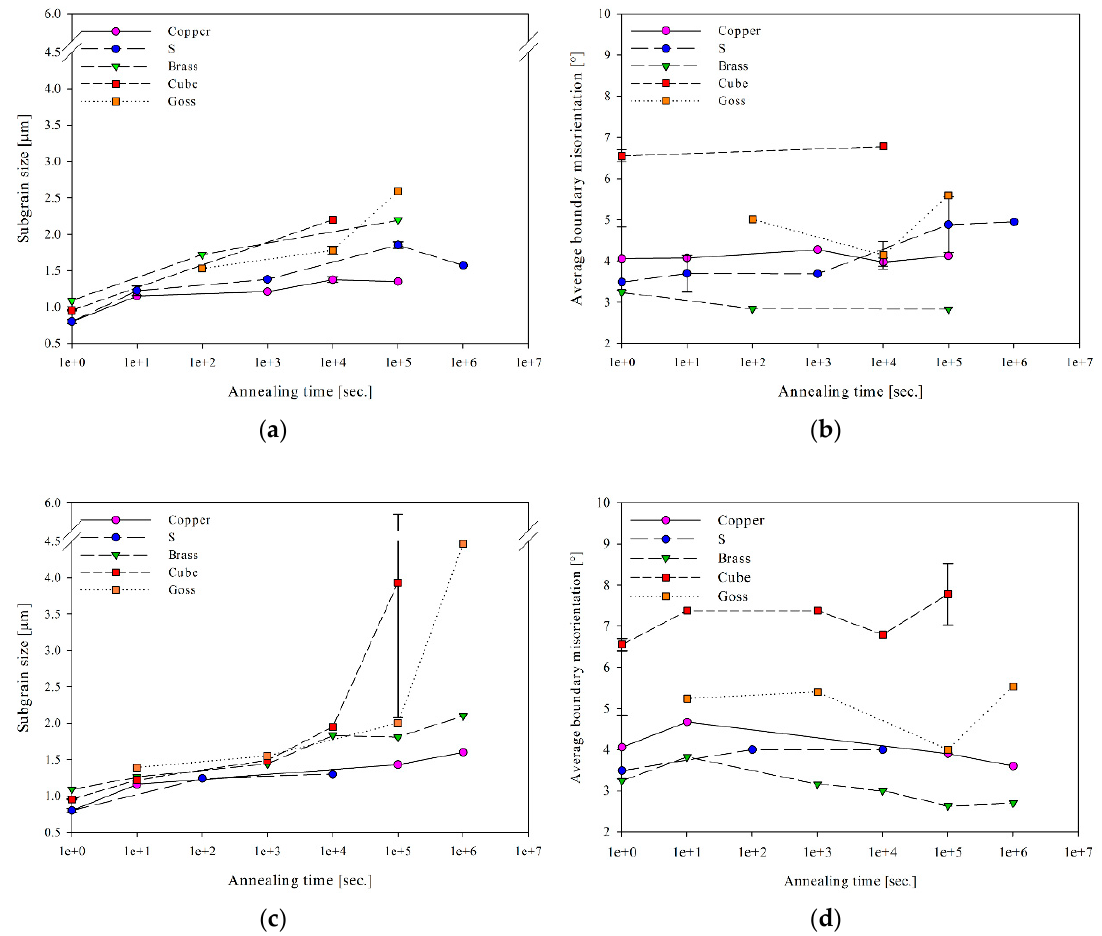
Figure 4. The evolution in average subgrain size ( a, c ) and boundary misorientation ( b, d ) during annealing of HP Al at 200 °C and at 220 °C, respectively. The as-deformed state is given at t = 1 s. Error bars reflect the scattering between several scans, while no error bar refers to an average value from one EBSD scan (with up to 1000 grains).